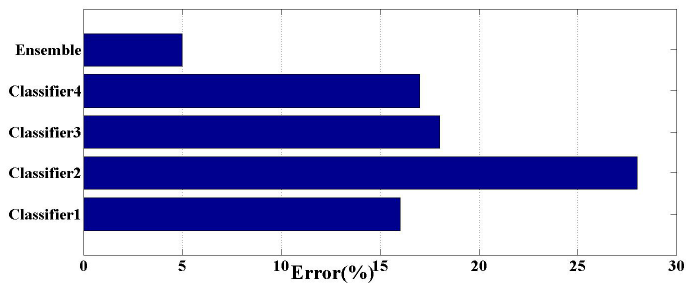
Figure 13. Error (%) for different classifiers when the test dataset is D5-SPT-Tst calculated using Equation (6), considering accelerometer readings only.